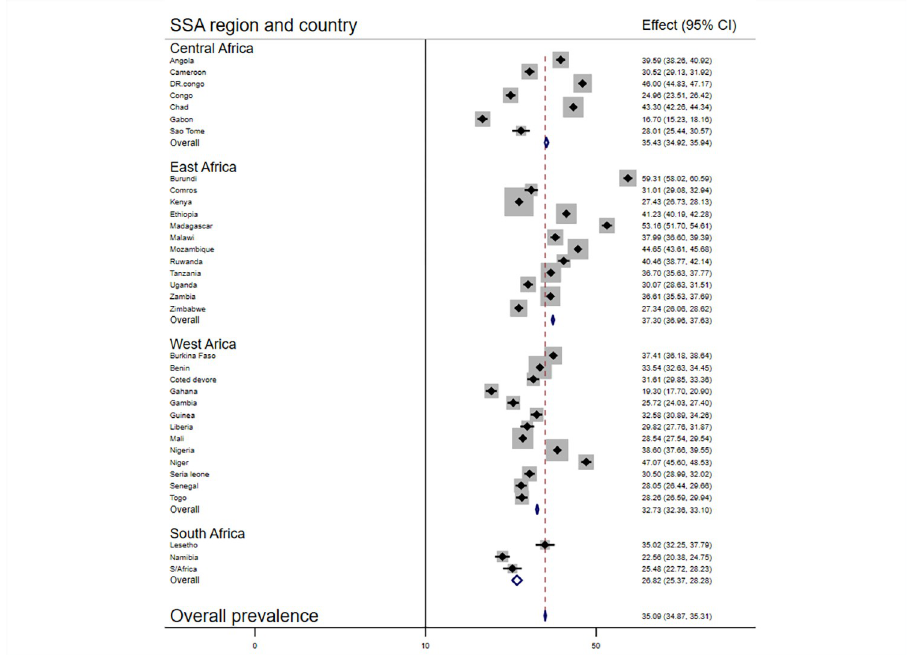
Fig 1. Forest plot of Pooled prevalence of stunting among children aged 6–59 months: Evidence from recent DHS data of 35 SSA countries.